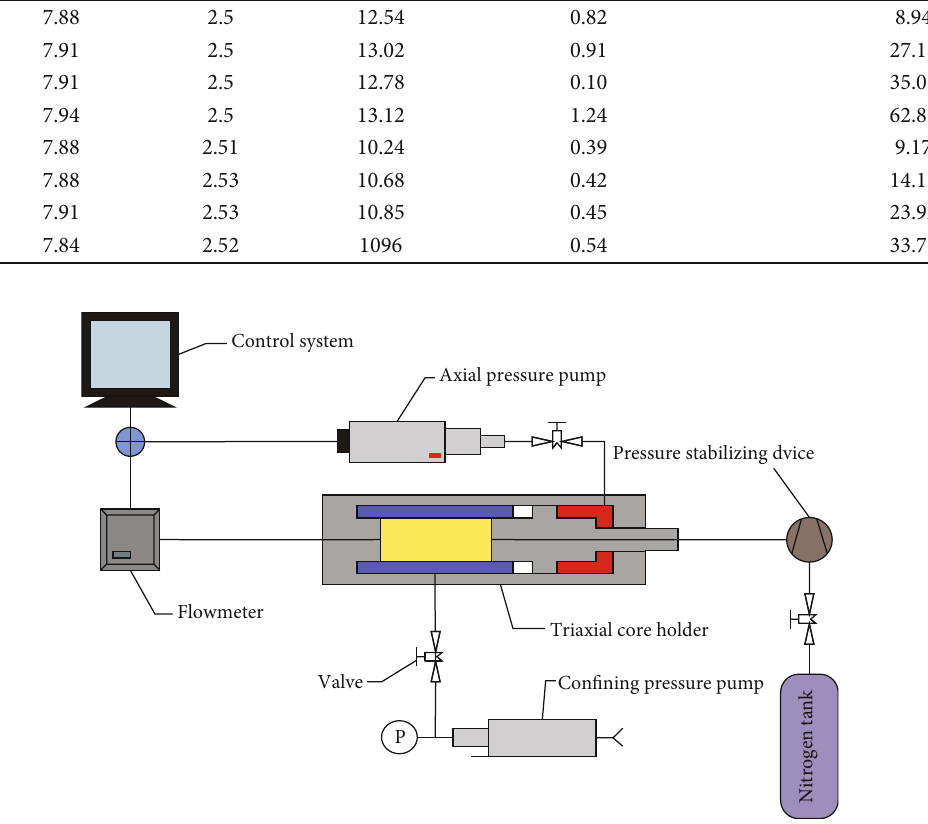
Figure 1: Flowchart of the experimental design of crack creation